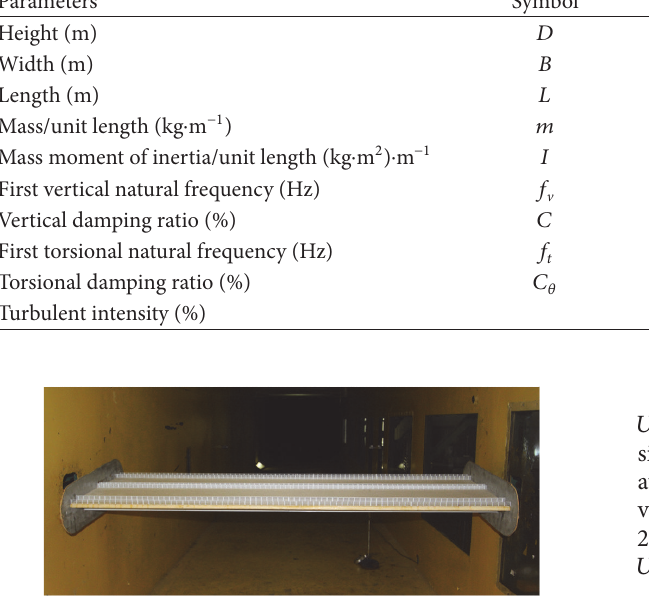
Figure 2: Dynamic testing